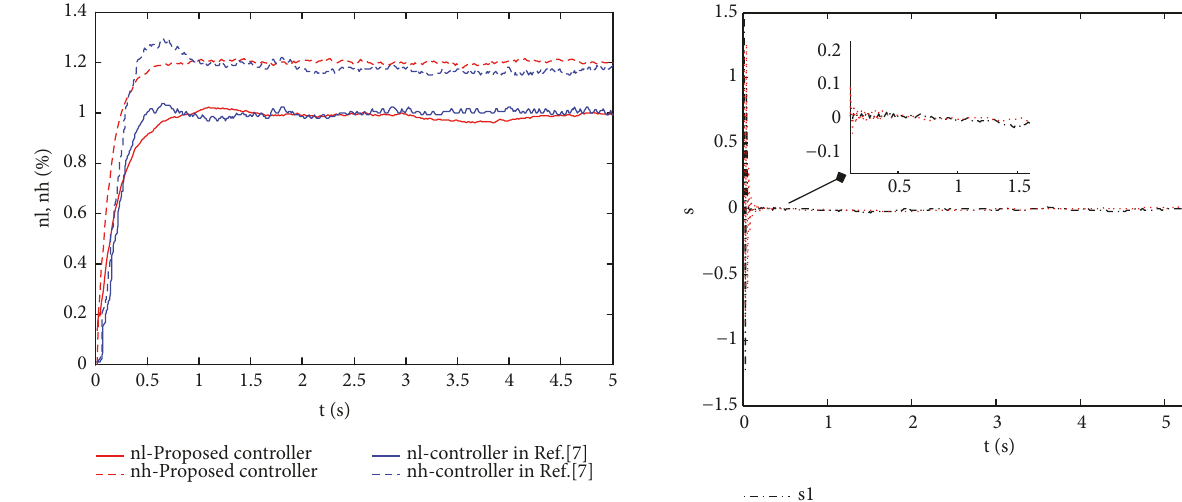
Figure 3: Step response results under control ( T =0.015s, P =3).